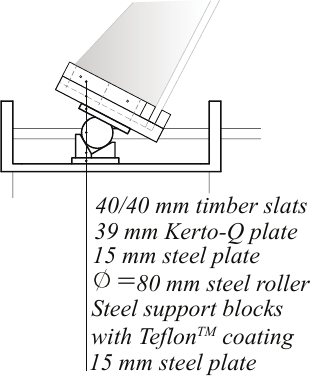
Figure 9. Experimental setup side support detail.